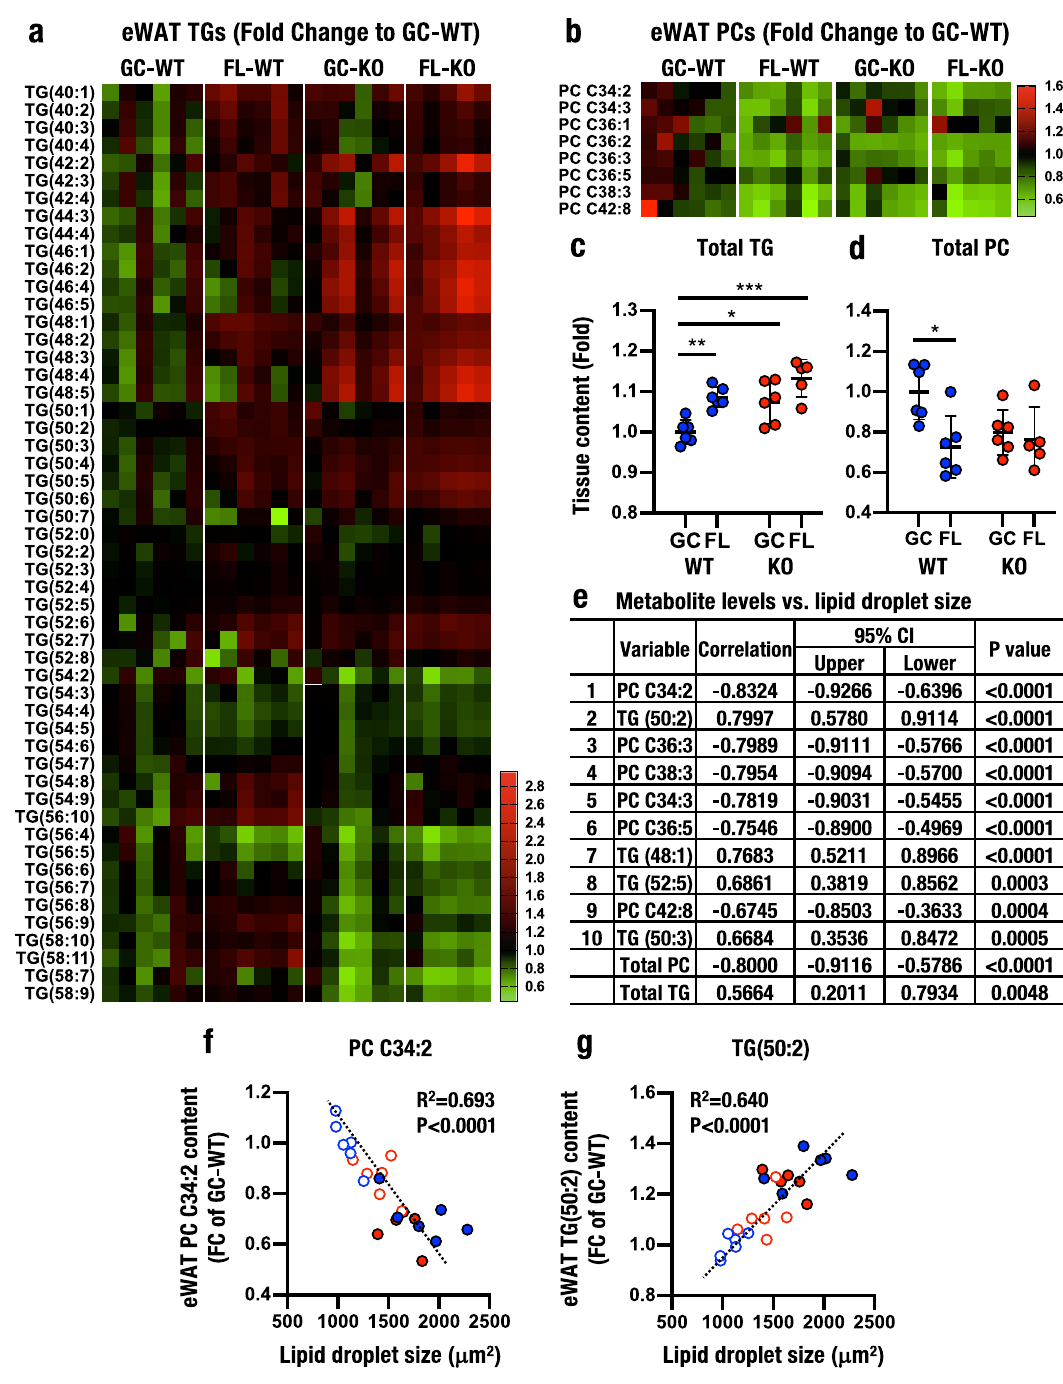
Fig. 5 Lipid metabolism in eWAT. a , b Heatmap analyses of triacylglycerol ( a ) and phosphatidylcholine ( b ) levels in eWAT at R + 2. The means of GC-WT/ R + 2 are set to one. c , d Total triacylglycerol ( c ) and phosphatidylcholine ( d ) levels in the eWAT of WT (blue) and Nrf2 KO (red) mice. The results are presented as the fold change compared to GC-WT mice and the means ± SD. Statistical analyses were performed using ANOVA followed by Tukey ’ s post hoc test. * P < 0.05, ** P < 0.01 and *** P < 0.001. e – g Multivariate analysis ( e ) and levels of individual metabolites PC C34:2 ( f ) and TG (50:2) ( g ) to determine the relationship between lipid levels and the lipid droplet size in eWAT. Notably, the levels of PC C34:2 and TG (50:2) show very good correlations with the lipid droplet size. P values and Pearson ’ s correlation coef fi cient R ( e ) or R 2 ( f , g ) values with the corresponding 95% con fi dence interval (95% CI) are displayed ( e ). The top 10 metabolites and total triacylglycerol and phosphatidylcholine levels are indicated ( e ).